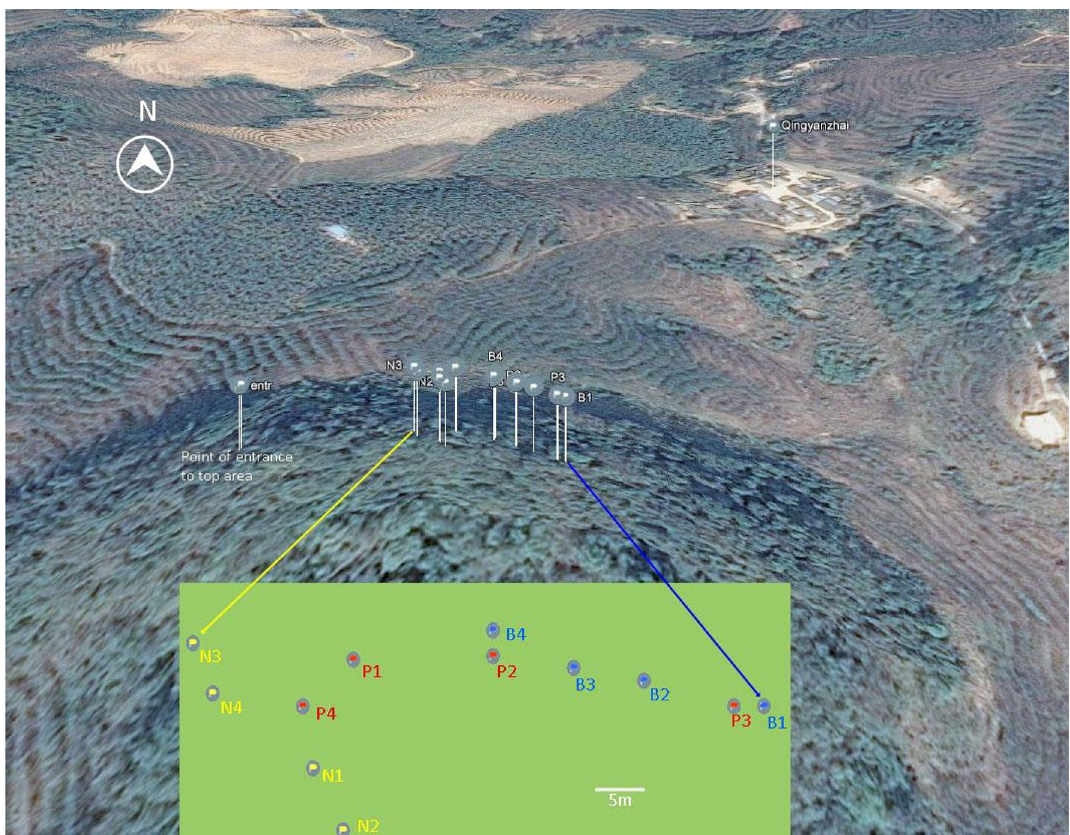
Figure 6. Map of the study site with approximate position of analysed trees (aerial perspective from Google Maps 2018). GPS positions were obtained less than 1 m from the tree trunks. The distance from N3 to B1 is approximately 60